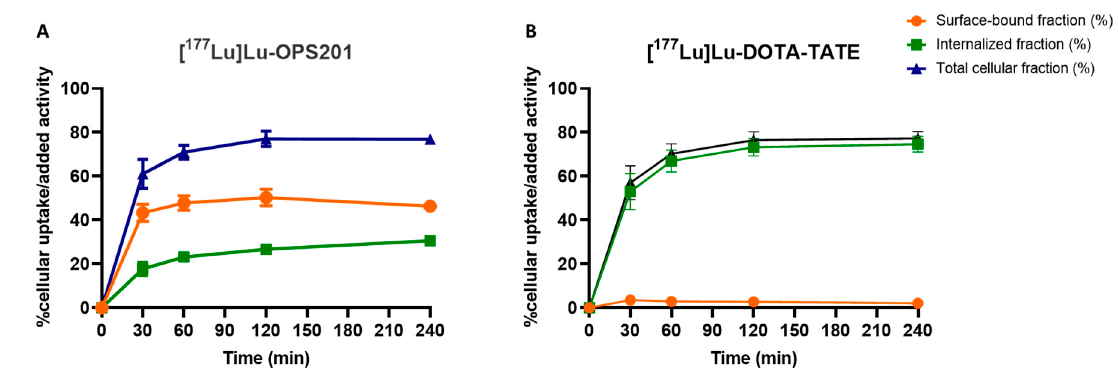
Figure 3. Cellular uptake of [ 177 Lu]Lu-OPS201 ( A ) and [ 177 Lu]Lu-DOTA-TATE ( B ). Data are representative of three independent experiments, each performed in triplicate.